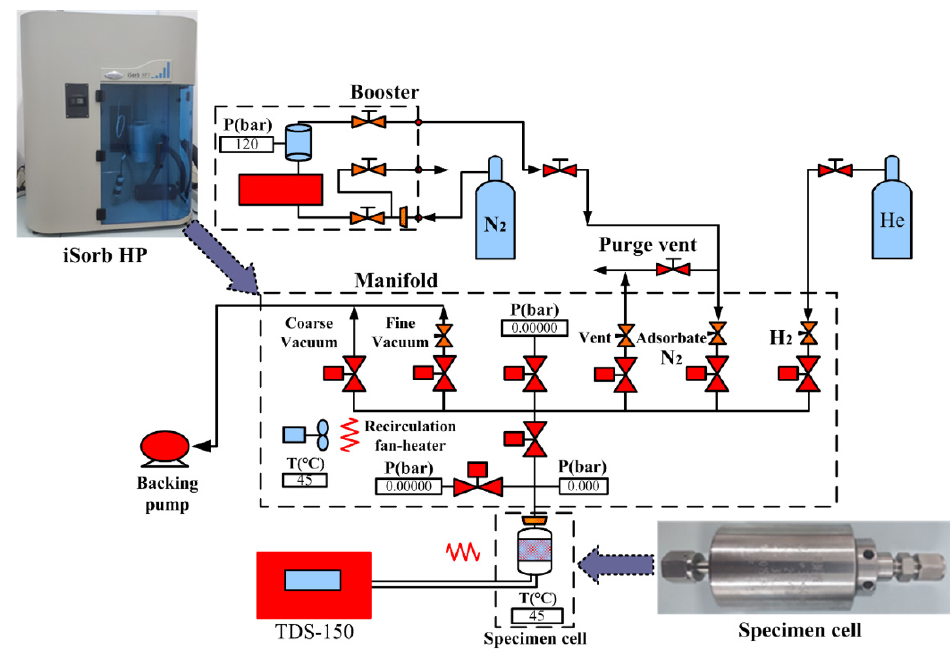
Figure 9. Schematic of the gas adsorption test system (the figure has been adapted from a Shandong University of Science and Technology introduction to test systems in gas diffusion dynamics). Table 7. Langmuir parameters of shale